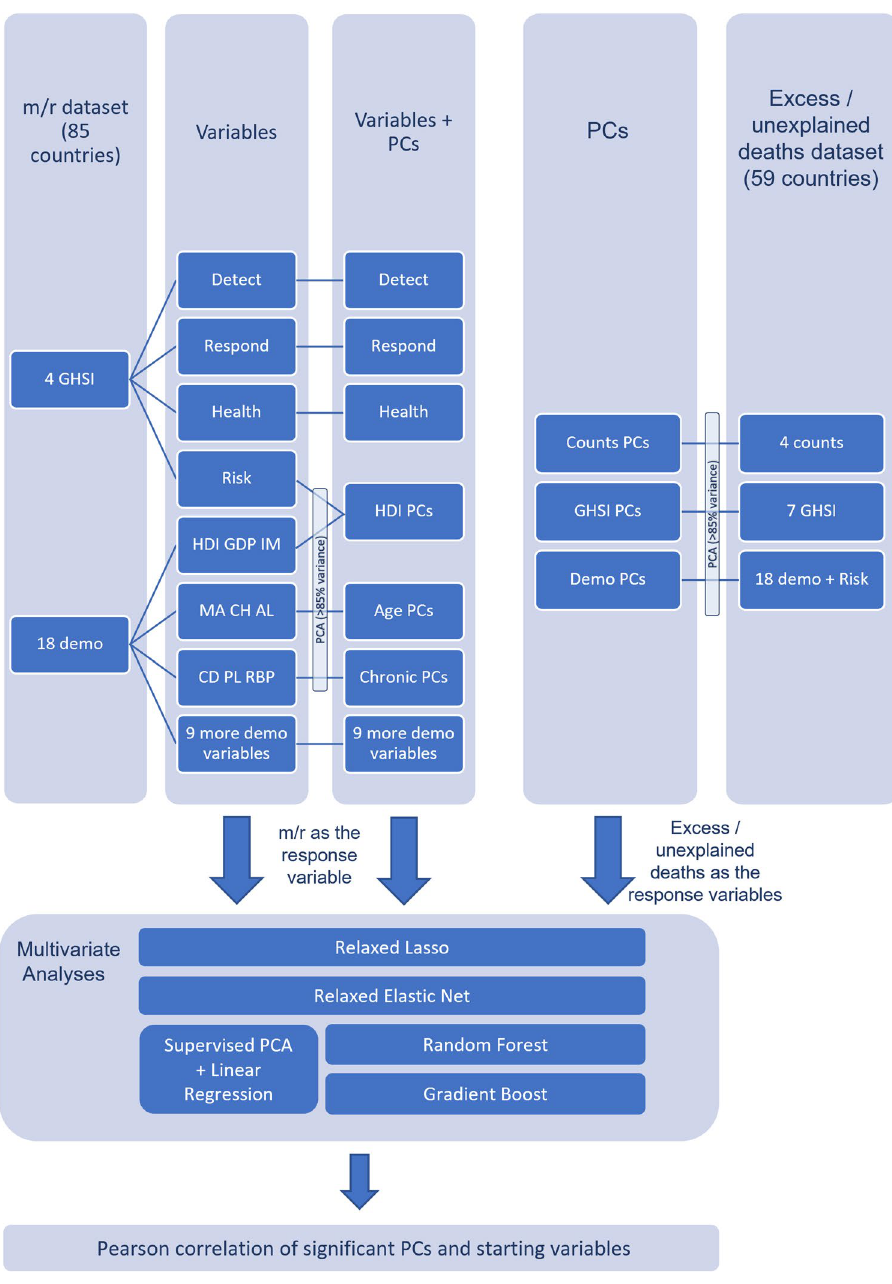
Figure 7. Flowchart of the methods applied on each of the datasets. m/r – disease severity measure, GHSI – Global Health Security Index, demo – demographic, counts – COVID-19 counts, PCs – principal